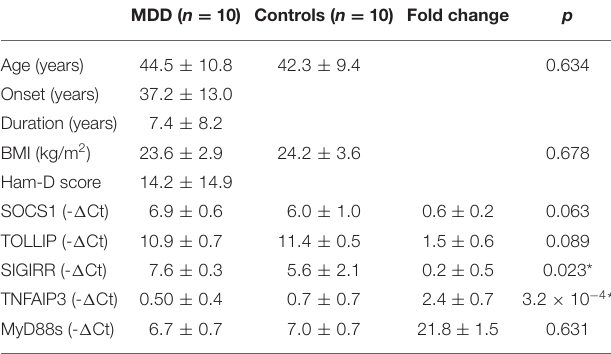
TABLE 3 | Demographic data and mRNA levels from TNF- α secreting